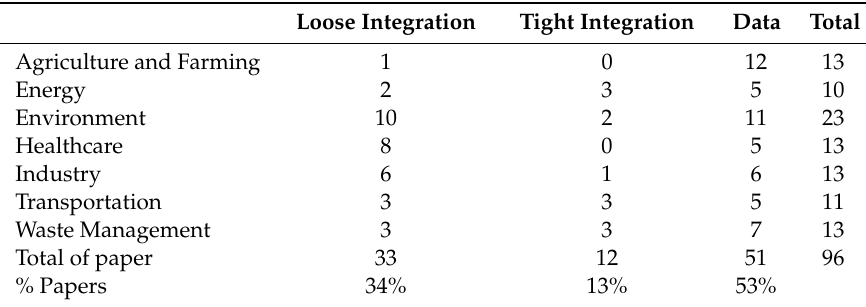
Table 16. Classification of papers by